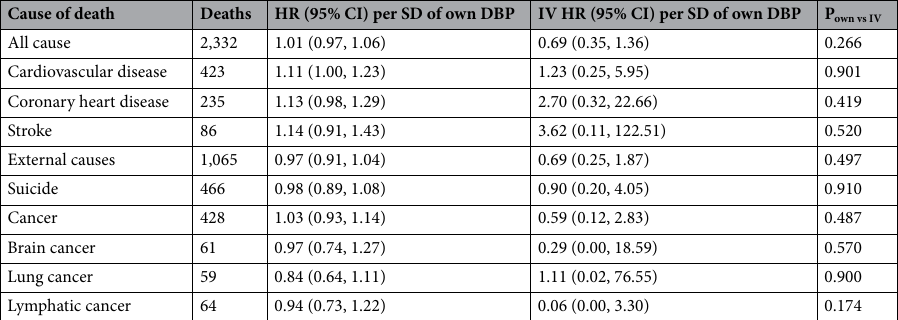
Table 3. Adjusted hazard ratios (HR) for paternal mortality (i) per standard deviation (SD) of own diastolic blood pressure (DBP) and (ii) per SD of own DBP, using son’s DBP as an instrumental variable (IV) within the subset having data on own DBP. DBP was pre-adjusted for regional patterns, secular trends and age at examination and its SD was 9.22 mmHg. Cox proportional hazards models with age as the time axis were adjusted for educational and occupational socioeconomic position. One-sample IV estimates were made using the ratio method. P own vs IV was derived from Durbin-Wu-Hausman tests comparing the two HR. N = 66,567 fathers at risk of mortality. Rarer causes of death (< 50 deaths in the data subset) are